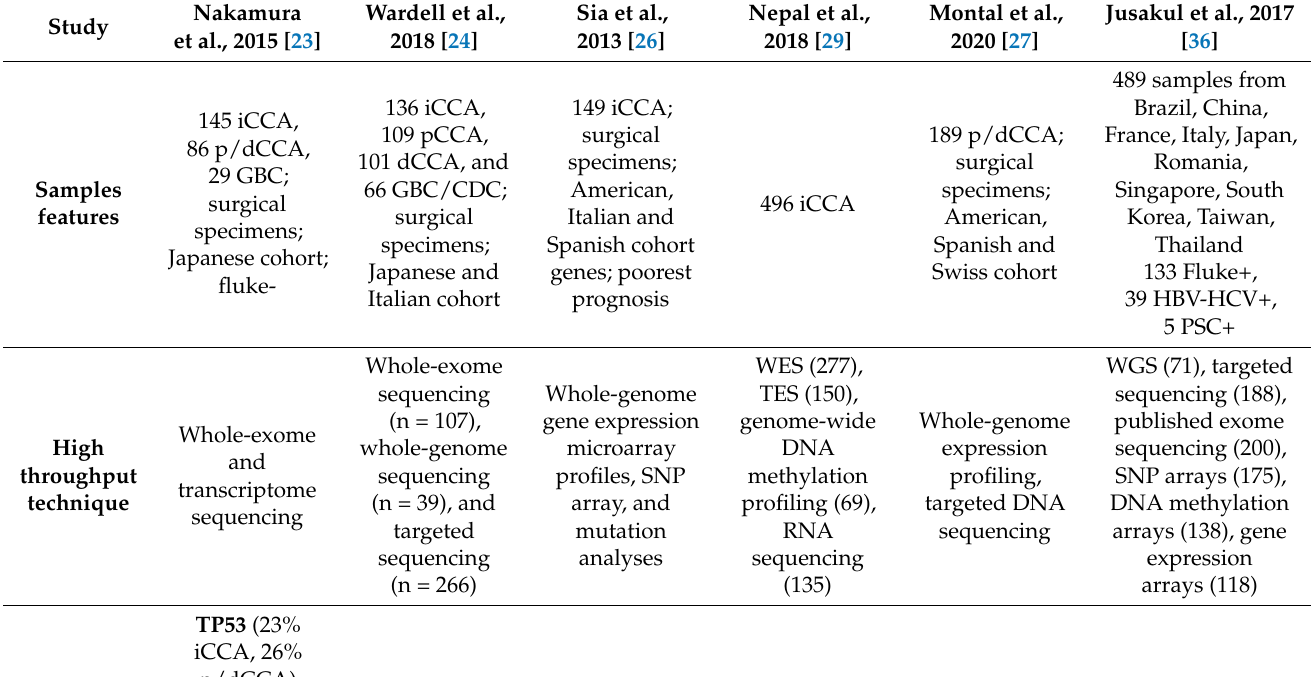
Table 1. Comparison of the main polyetiological studies concerning CCA molecular clustering, considering samples features, high-throughput techniques, molecular signatures, clusters, and potential targeted therapy related to driven genetic